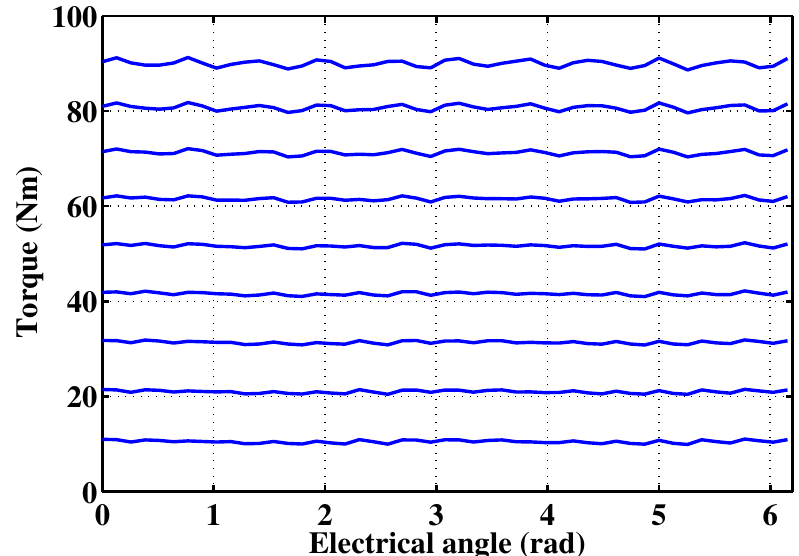
Figure 17. Torque-angle characteristics of the FSPMSM equipped with the proposed winding ar- rangement vs. the current density. Legend: (bottom) J = 1 A/mm 2 , (top) J = 9 A/mm 2